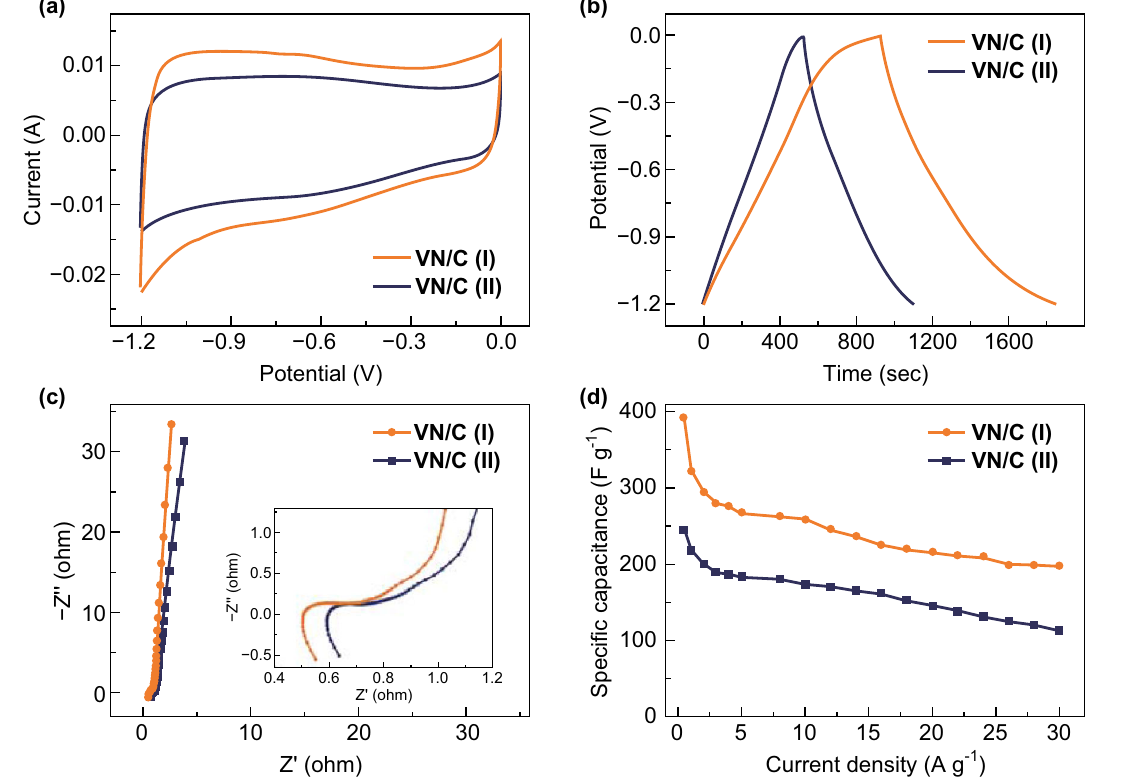
Fig. 4 a CV, b GCD, c EIS curves, and d the specific capacitances of the VN/C (I) and VN/C (II) at different current densities (scan rate = 10 mV s - 1 in 6.0 M KOH aqueous